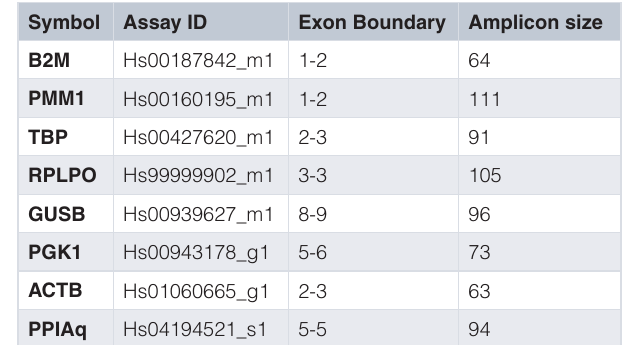
Table 2. Additional assay